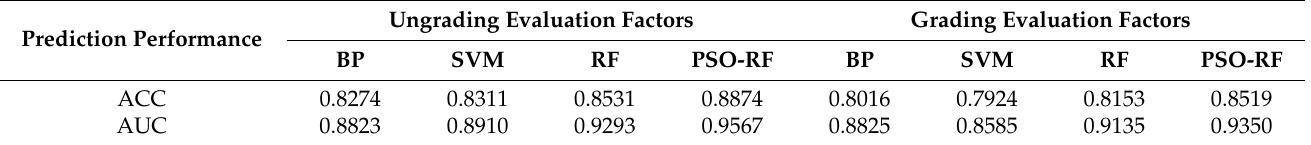
Table 9. AUC value and accuracy of the prediction results with ungrading and grading evaluation